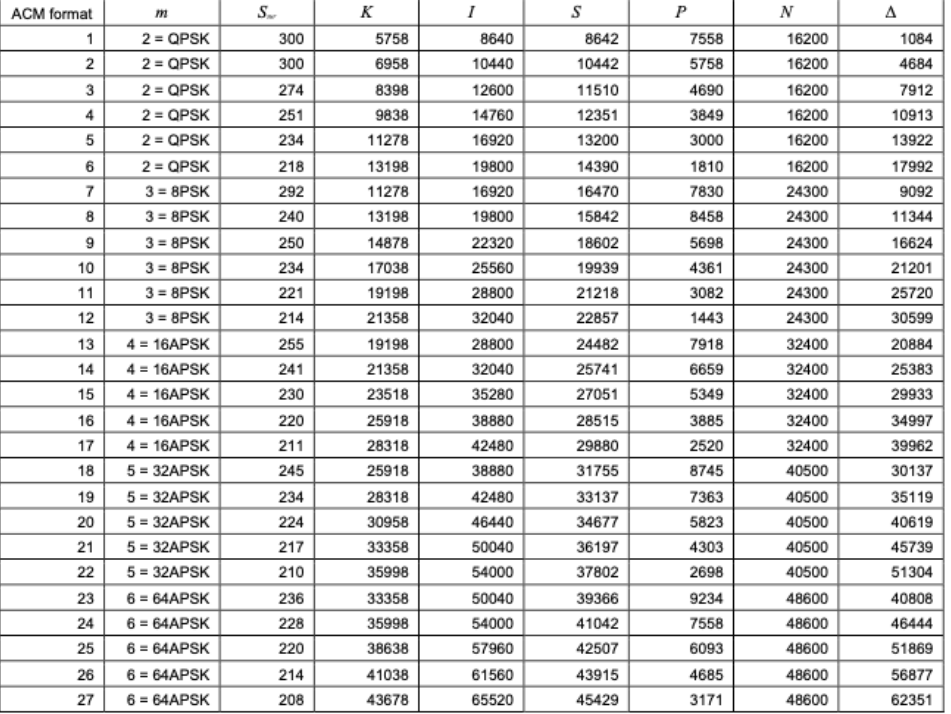
Figure A1. Variable managed parameters for 27 selected ACM